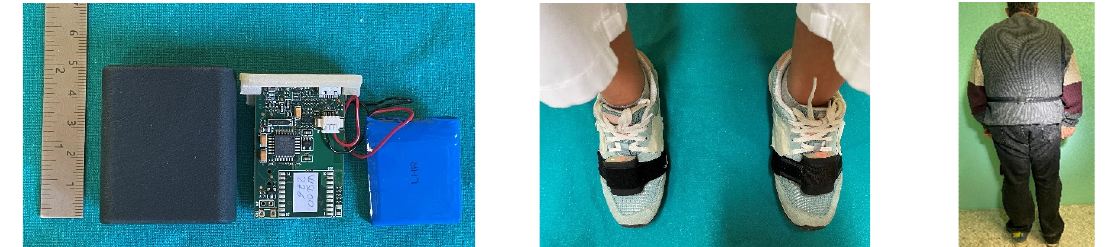
Figure 1. Circuit board of an Inertial Measurement Unit (IMU) and applications.